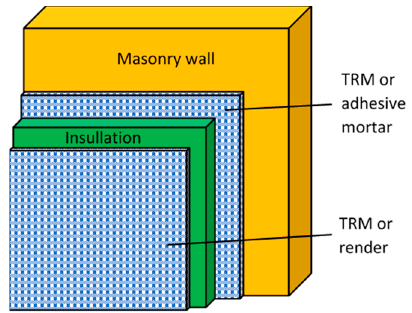
Figure 1. Schematic view of combined structural and energy retrofitting system on one side of the masonry wall.